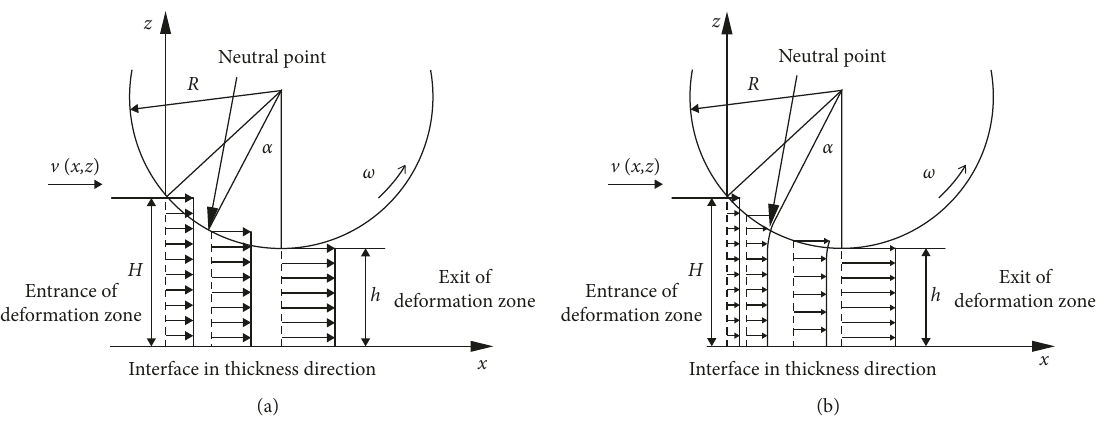
Figure 1: Different assumptions of distributions in the thickness direction of flow velocity in rolling direction: (a) homogeneous dis- tribution and (b) inhomogeneous